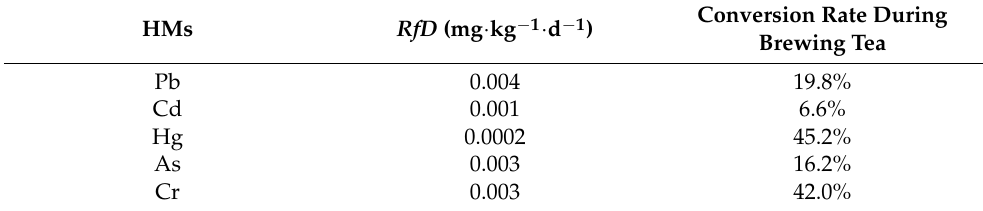
Table 3. Reference values of different heavy metals in THQ